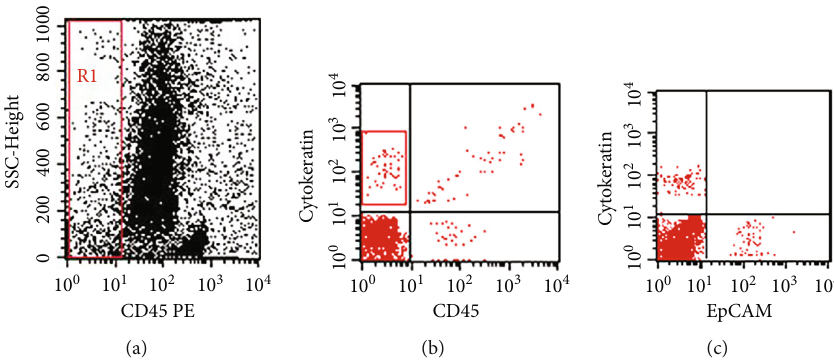
Figure 3: Flow cytometric detection of circulating tumor cells (CTCs). (a) CD45 and side scatter histogram was used to select the CD45 negative cells (R1). (b) The expressions of cytokeratin in CD45 negative. (c) CTCs were de fi ned as EPCAM + cytokeratin +